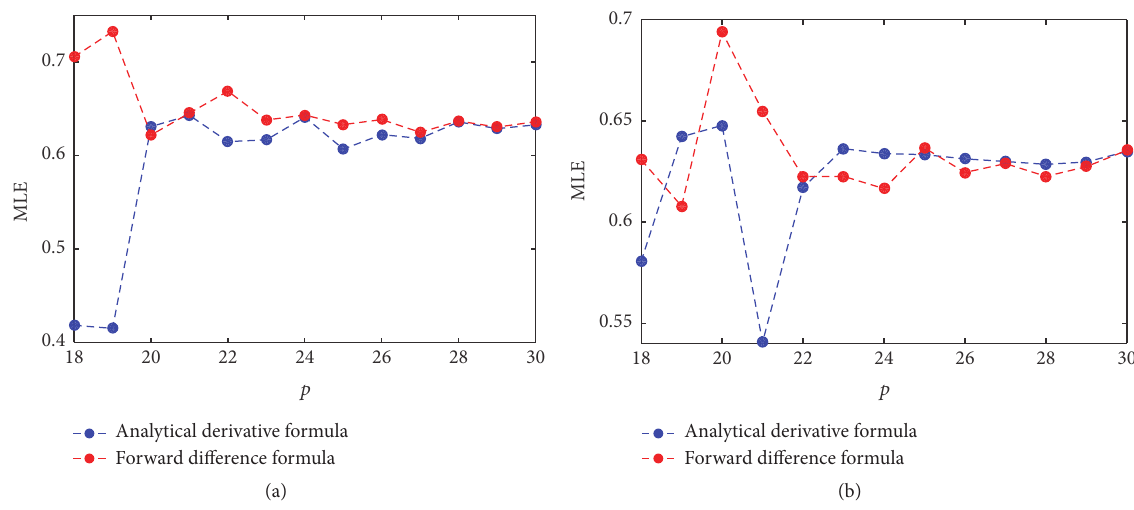
Figure 16: MLE evaluation in two different methods using 𝑓 3 (𝑥) starting at 𝑥 0 = 0.125 at (a) 𝜆 = 3.984375 and (b) 𝜆 = −1.984375 .